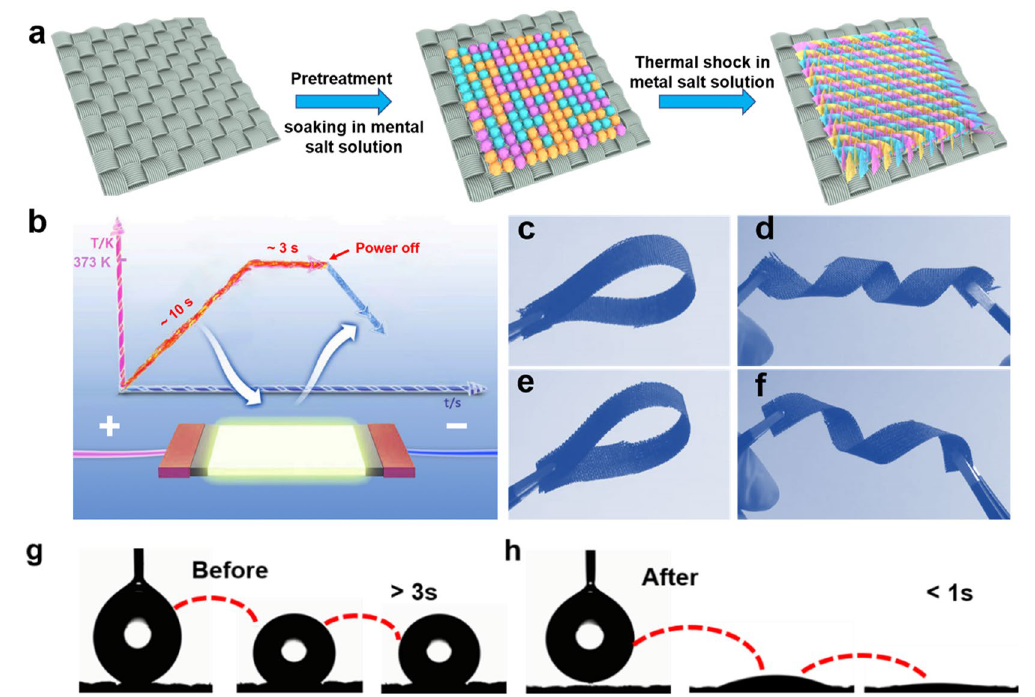
Fig. 1 a Schematic illustration process of TM-LDHs@CC synthesized by using a thermal shock approach in solution system. b Schematic diagram of the temperature evolution of solution system with time during 13 s thermal shock. Digital images for the appearance and flexibility (bending and twisting) of c, d primary carbon cloth (Before) and e, f NiCo LDH@CC (After). Diffusion process of water molecules on g pri- mary carbon cloth and h NiCo